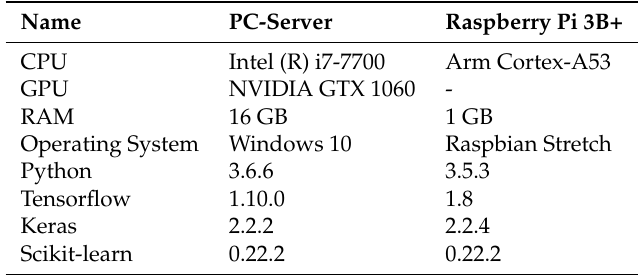
Table 2. Hardware and Software for Training and Testing